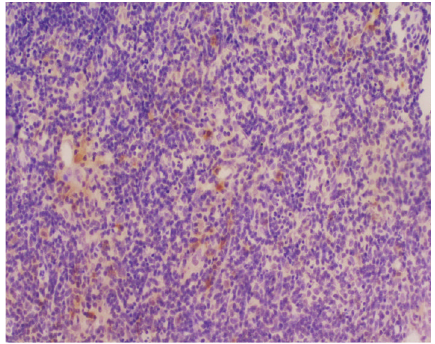
Figure 10: Treated group: 6 hours; Caspase-3 ×